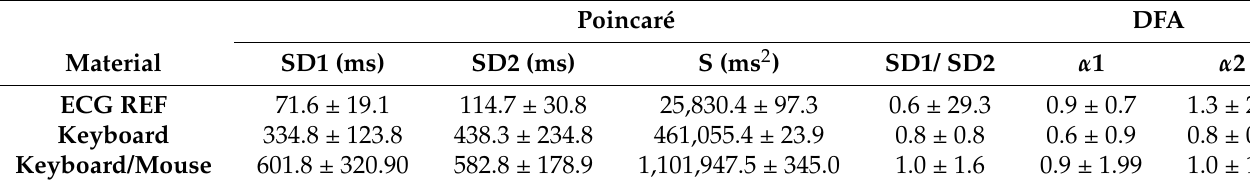
Table 3. Comparative analysis of DFA and Poincaré features for data collected with each electrode material.